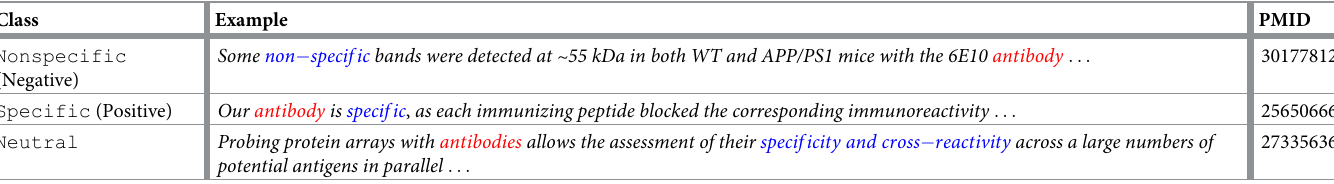
Table 1. Example snippets of the antibody specificity classes and the PubMed IDs (PMID) of their sources. Class